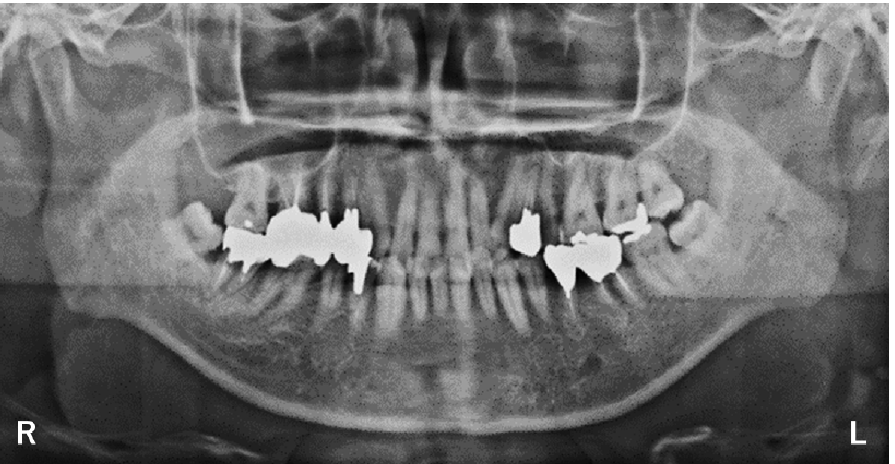
Figure 1. A panoramic radiographic view of the TMJ showed a normal shape in both condyles. R: right. L: left.